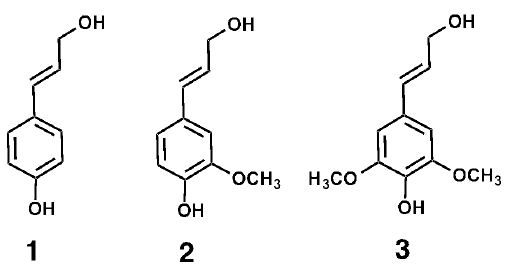
Figure 1. The structure of the monolignols p -coumaryl alcohol ( 1 ), coniferyl alcohol ( 2 ) and sinapyl alcohol ( 3 ). These compounds are synthesized in the plant cell and transported to the cell wall where they can undergo oxidative polymerization to form lignin.